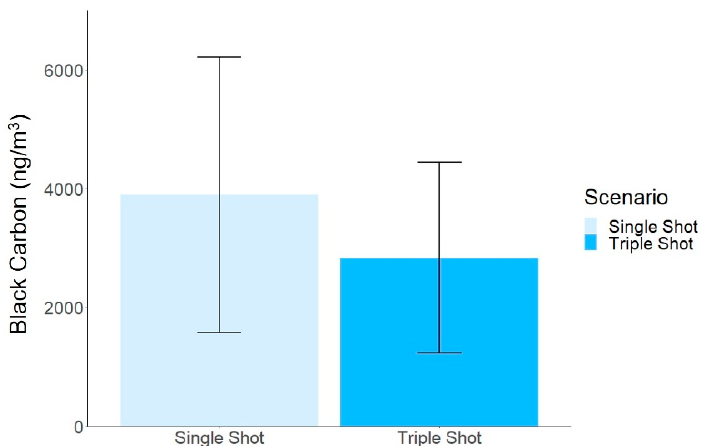
Figure 4. Average Black Carbon Concentrations. Averages and standard deviations of single (3893 ± 2316 ng/m 3 ) and triple shot (2836 ± 1606 ng/m 3 ) are reported ( n = 4). Statistically significant differences were not observed between single and triple shot scenarios using the Welch’s t-test ( p = 0.543).